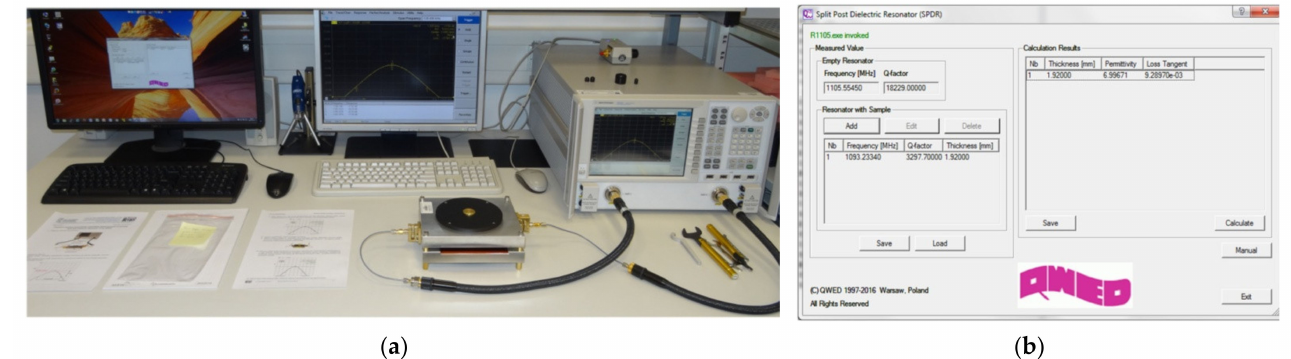
Figure 2. Laboratory stand for measuring dielectric parameters: ( a ) Hardware; ( b ) Software.